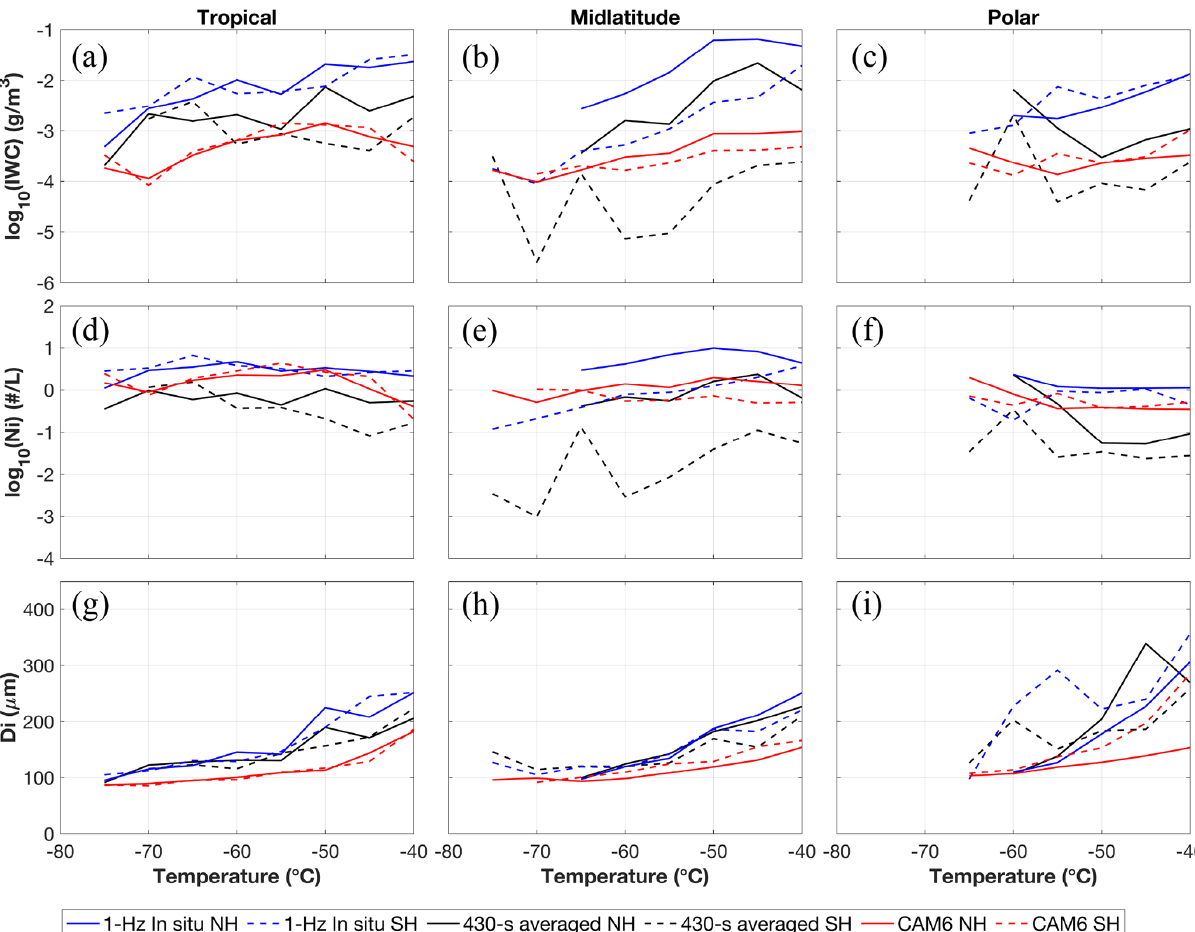
Figure 5. Geometric means of (a–c) IWC and (d–f) N i , as well as (g–i) linear averages of D i at 5 ◦ C temperature intervals between − 80 and − 40 ◦ C, compared between 1Hz in situ observations (blue lines), 430s averaged observations (black lines) and CAM6-nudg (red lines). Observed and simulated microphysical properties are binned by six latitudinal regions, where NH is denoted by solid lines, and SH is denoted by dashed lines. The number of samples for 1Hz observations at temperatures ≤ − 40 ◦ C in the Northern (Southern) Hemisphere tropical, midlatitude and polar regions are 173930 (15569), 100615 (3809) and 6704 (2606), respectively. The number of samples for 430s averaged observations in these regions are 355082 (40683), 233546 (26850) and 24083 (10252), respectively. The number of samples for CAM6-nudg data in these regions are 3241592 (653110), 2052353 (590503) and 478844 (209662),